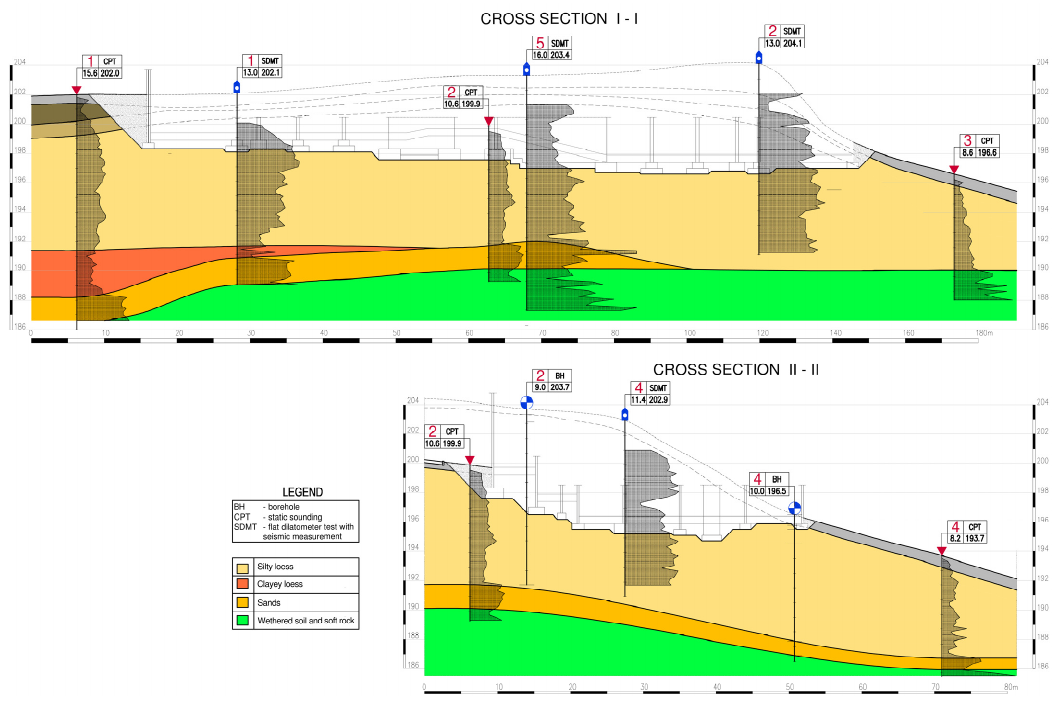
Figure 8. Geotechnical cross-sections.